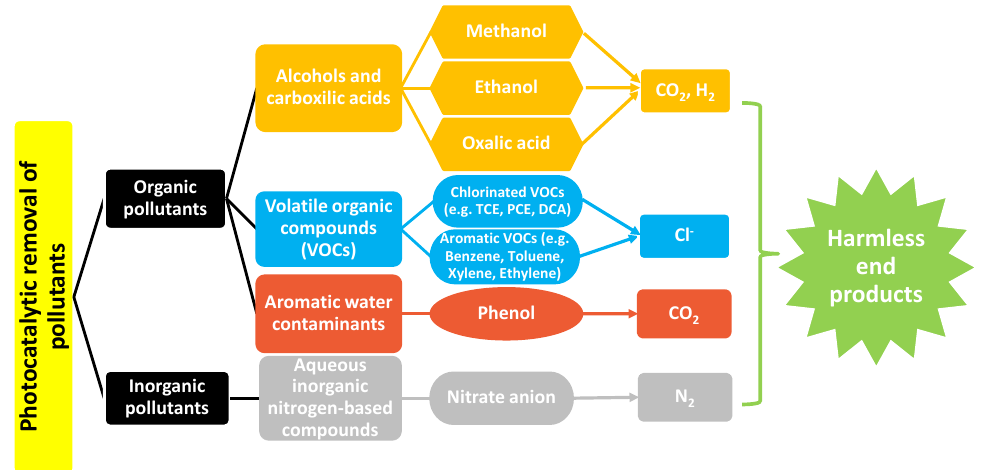
Figure 1. Schematic illustration of the manuscript structure and its objectives.